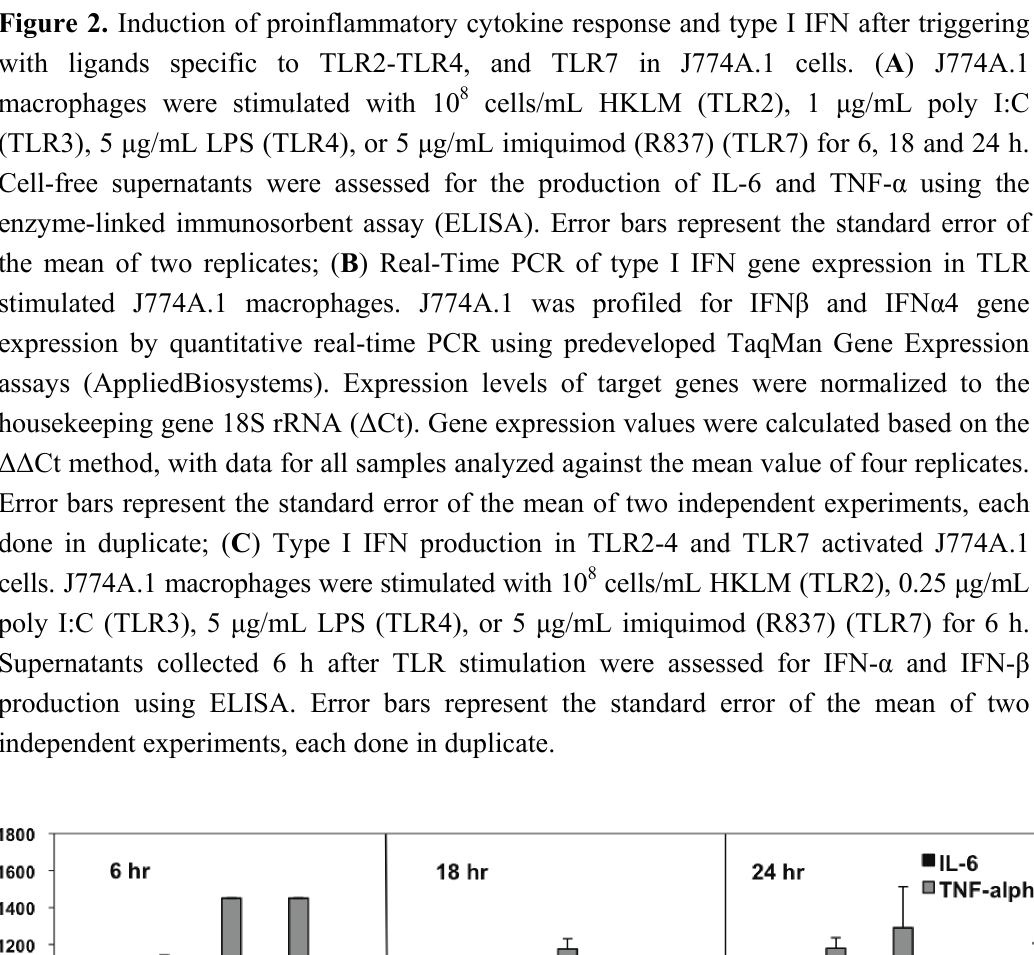
Figure 2. Induction of proinflammatory cytokine response and type I IFN after triggering with ligands specific to TLR2-TLR4, and TLR7 in J774A.1 cells. ( A ) J774A.1 macrophages were stimulated with 10 8 cells/mL HKLM (TLR2), 1 μ g/mL poly I:C (TLR3), 5 μ g/mL LPS (TLR4), or 5 μ g/mL imiquimod (R837) (TLR7) for 6, 18 and 24 h.